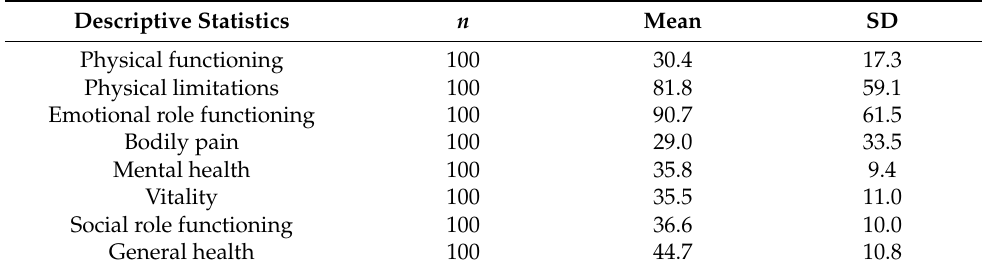
Table 2. The descriptive statistics for SF-36 health